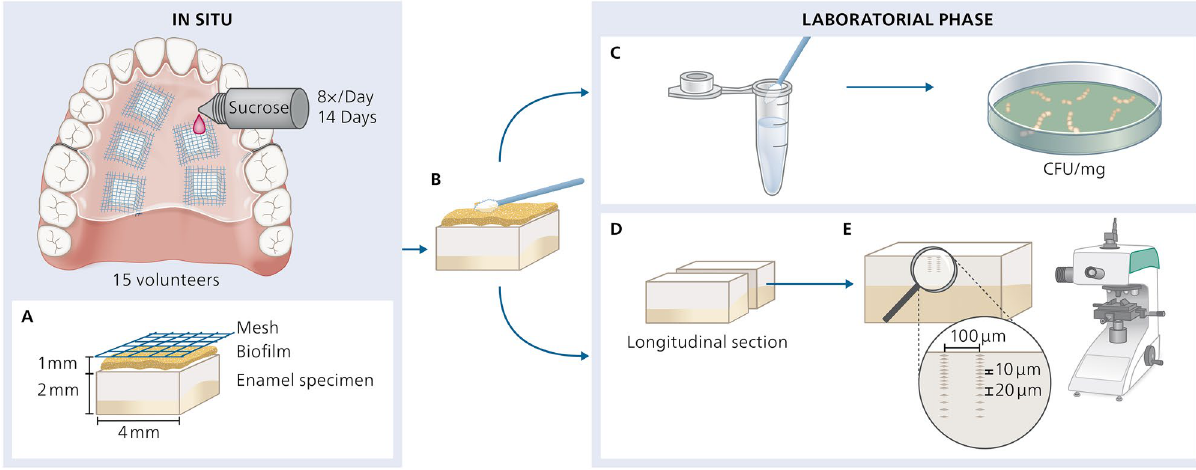
Figure 1. Study Design—Palatal appliance worn by the volunteers containing 5 bovine enamel specimens (4 × 4 × 2 mm 3 ) with artificial caries lesions infiltrated with a resin infiltrant. Specimens were rinsed with sucrose 8 times/day for 14 days. ( A ) Mesh net placed 1 mm over the specimens for allowing plaque accumulation. ( B ) Specimens removed from the appliances after 14 days. ( C ) Biofilm collection from one specimen/appliance (n = 15/group) and determination of CFU/mg of total bacteria , S. mutans and Lactobacillus acidophilius . ( D ) Specimens sectioned longitudinally trough the center of the caries lesions (n = 1 specimen/group/appliance and n = 15 specimens/group). ( E ) Cross-sectional Knoop microhardness analysis. Two lines of indentations 100 µm apart from each other and up to a depth of 180 µm. Indentation interval was 10 µm up to 100 µm